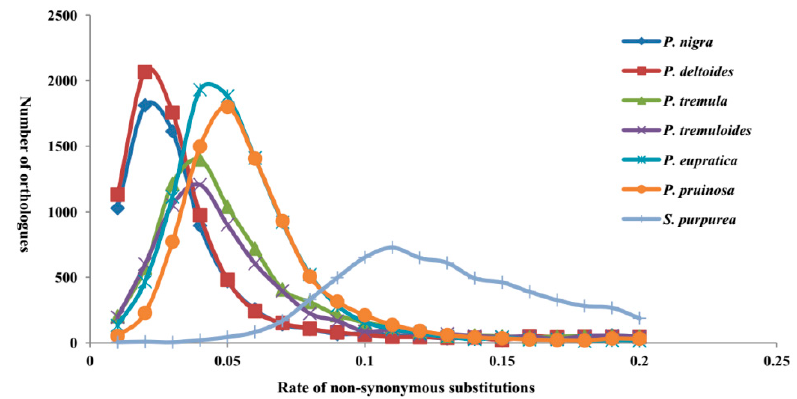
Figure 4. Distribution of the rate of non-synonymous substitutions (Ks) values of orthologous pairs 136 between P. trichocarpa and others. 137